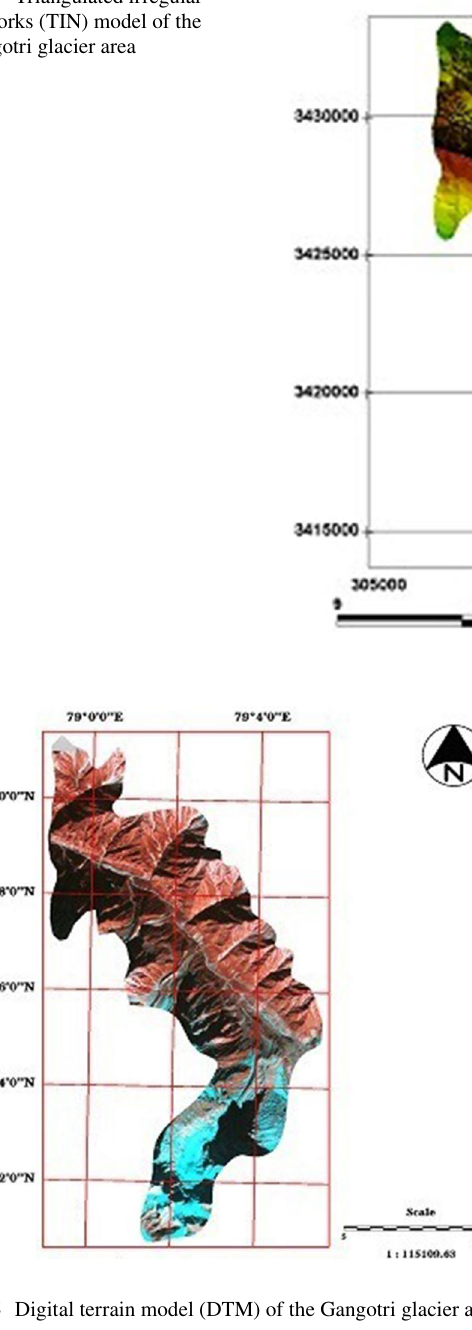
Fig. 4 Triangulated irregular networks (TIN) model of the Gangotri glacier area